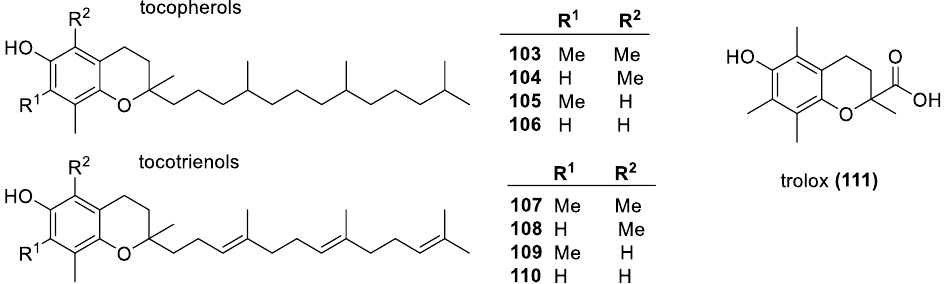
Figure 7. The structure of vitamin E-related antioxidants, including trolox a commonly applied reference compound.